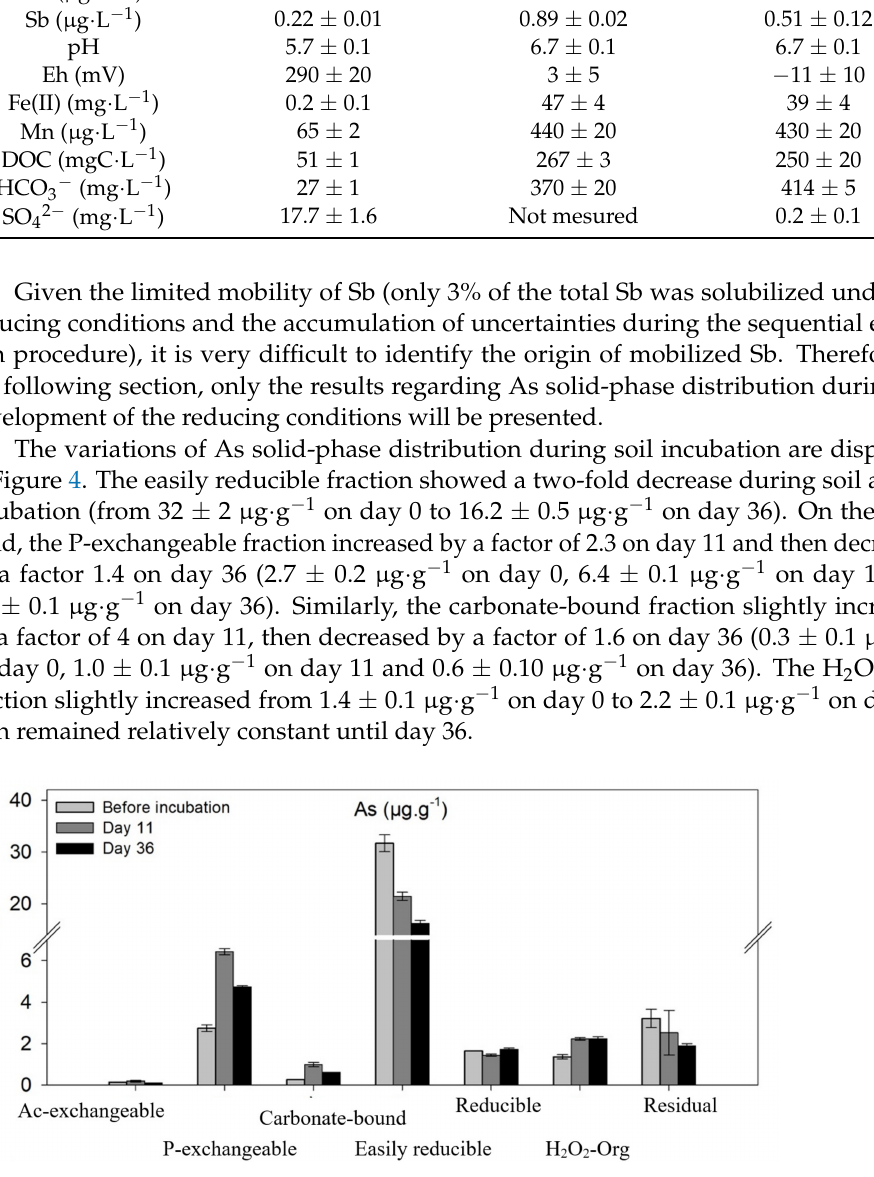
Figure 4. Solid-phase distribution of As during anoxic soil incubation ( µ g/g DW). Bars are repre- sented as the mean value ± standard variation ( n =